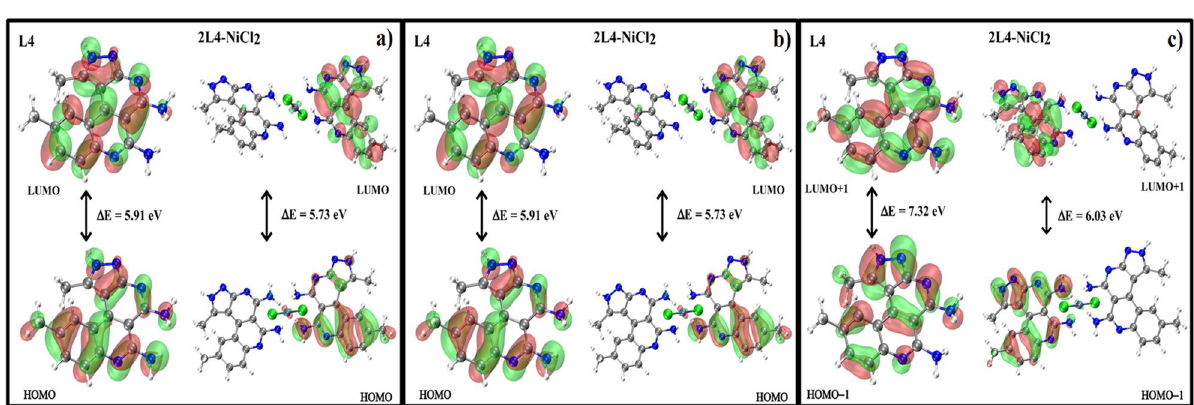
Figure 10. Scheme of optimized geometries (with M06L/def2-SVP method) for L4-NiCl 2 complexes and 2L4-NiCl 2 complexes with Ni 2+ with their respective relative Gibb free energies.